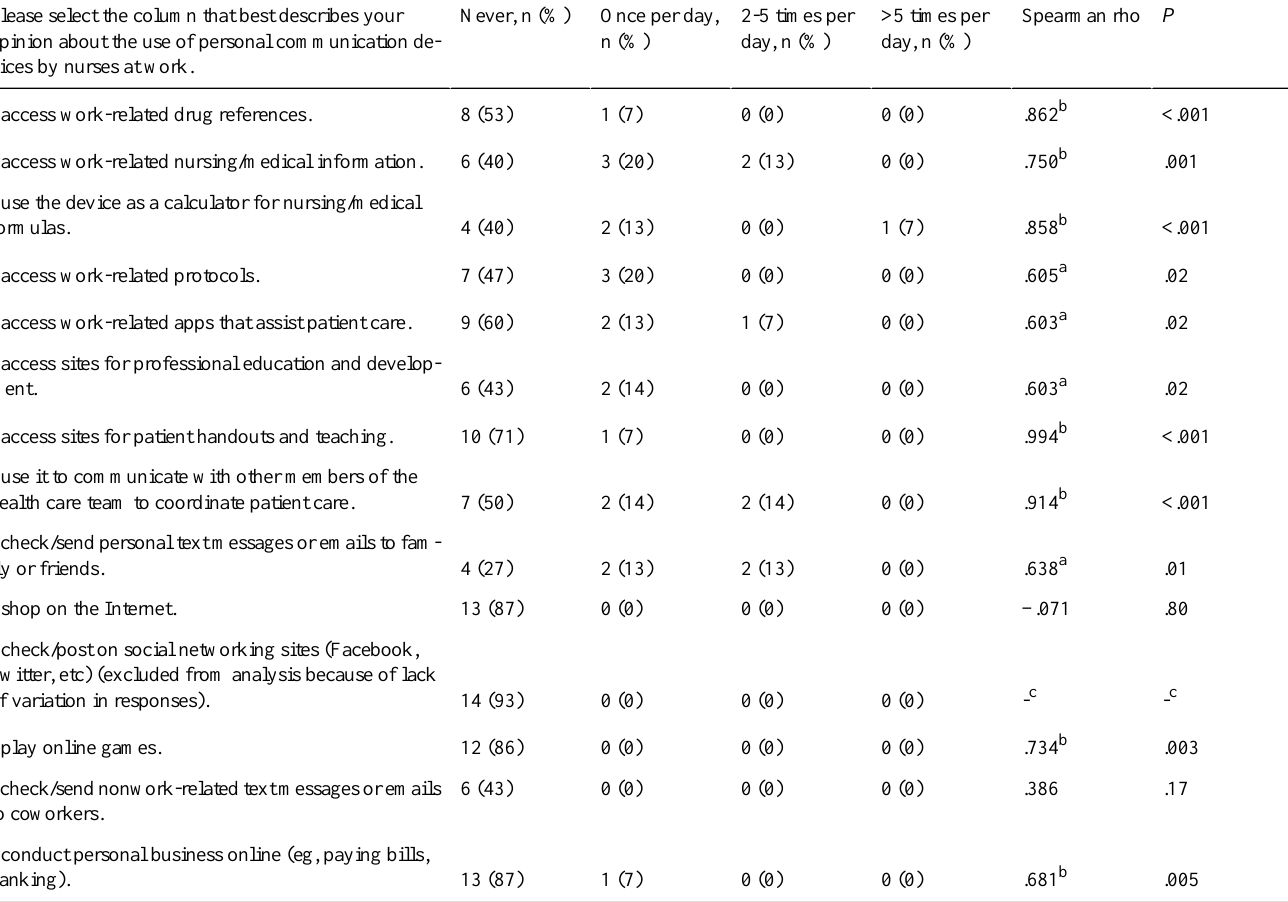
Table 2. Respondents with the same answers to both online pilot surveys for Group 1: utilization